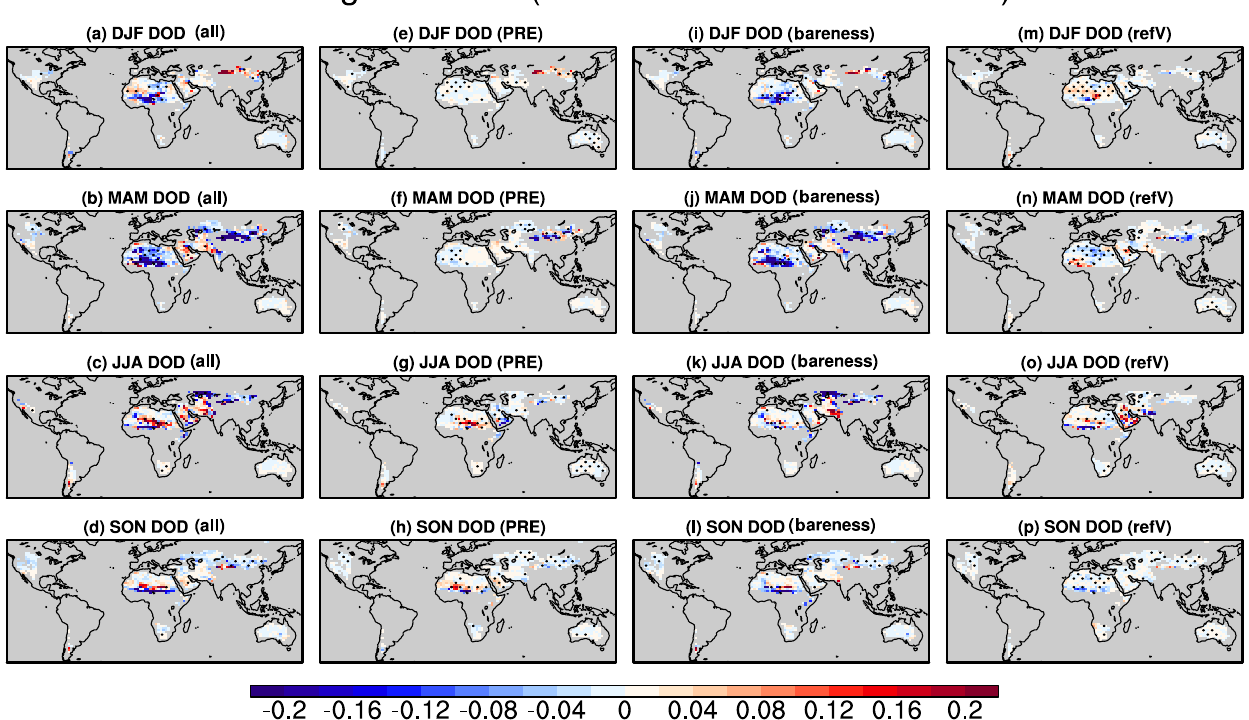
Figure 10. (a–d) Projected change of DOD in the late half of the 21st century under the RCP8.5 scenario by the regression model and output from seven CMIP5 models (same as Fig. 9), as well as contributions from each component, (e–h) precipitation, (j–i) bareness, and (m–p) surface wind speed. Dotted areas are regions with sign agreement above 71.4% among the models. To highlight DOD variations near the source regions, a mask of LAI ≤ 0 . 5 (from present-day climatology) is